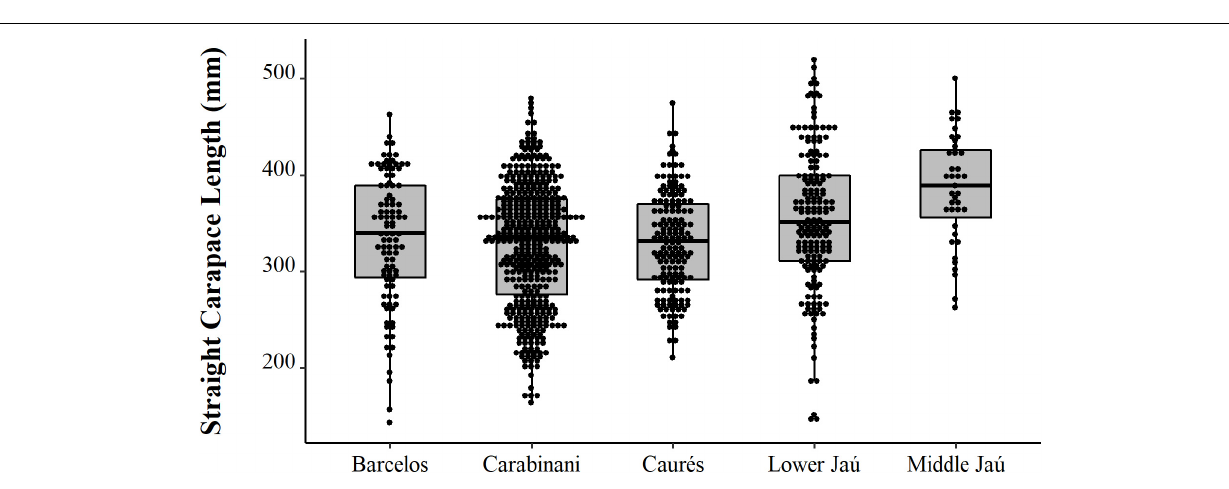
FIGURE 9 | Spatial distribution (points) and descriptive statistics (boxplot) of body size (SCL, mm) of Big-headed ( Peltocephalus dumerilianus ) in different locations of the Negro River region, Amazonas, between 1997 and